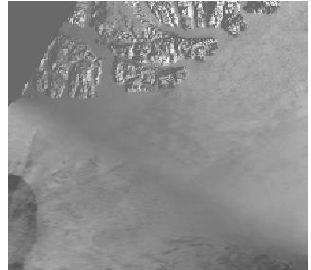
Figure.10 processed remote sensing image by the new graduation algorithm of Quarter